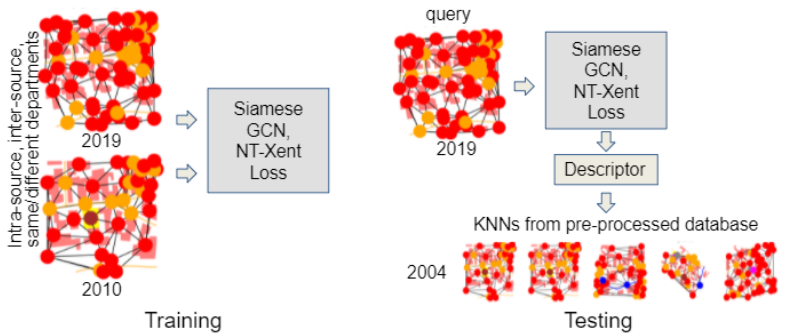
Figure 2. The main steps of the proposed approach GisGCN on graphs: training and